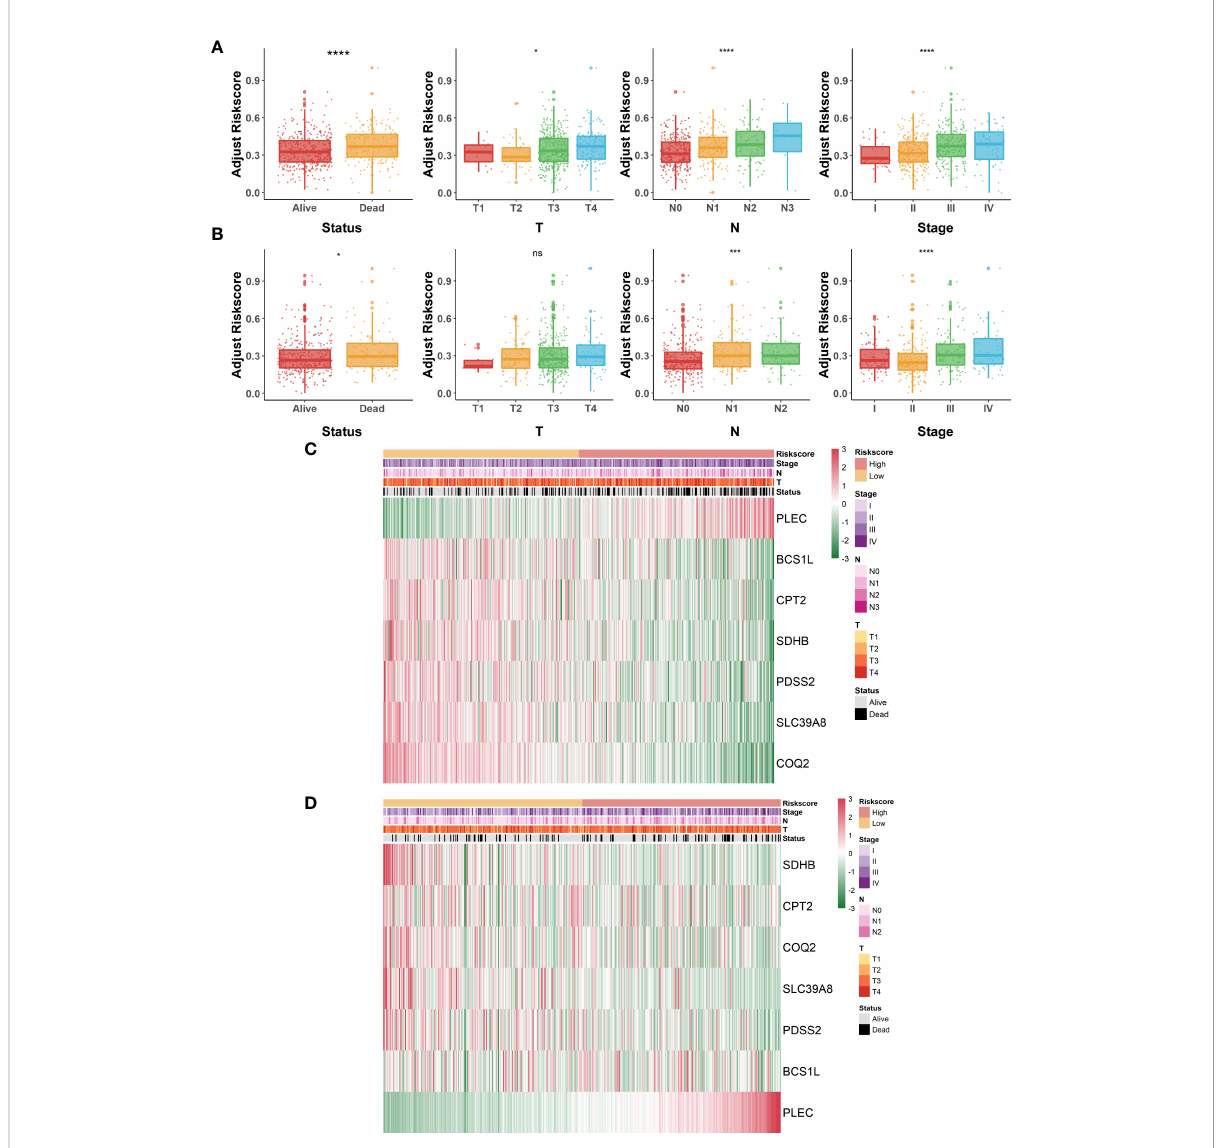
FIGURE 4 Correlation of lactate-metabolism-related risk signature and clinical indicators in COAD patients. (A, B) Box plots to present the relationship between different risk groups and clinicopathological characteristics of patients in GSE40967 (A) and TCGA-COAD (B) , respectively. (C, D) Correlation heat maps of risk signature-contained LMRGs and clinicopathological factors in GSE40967 (C) and TCGA-COAD (D) separately. *p < 0.05; ***p < 0.001; ****p < 0.0001; ns, not signi fi